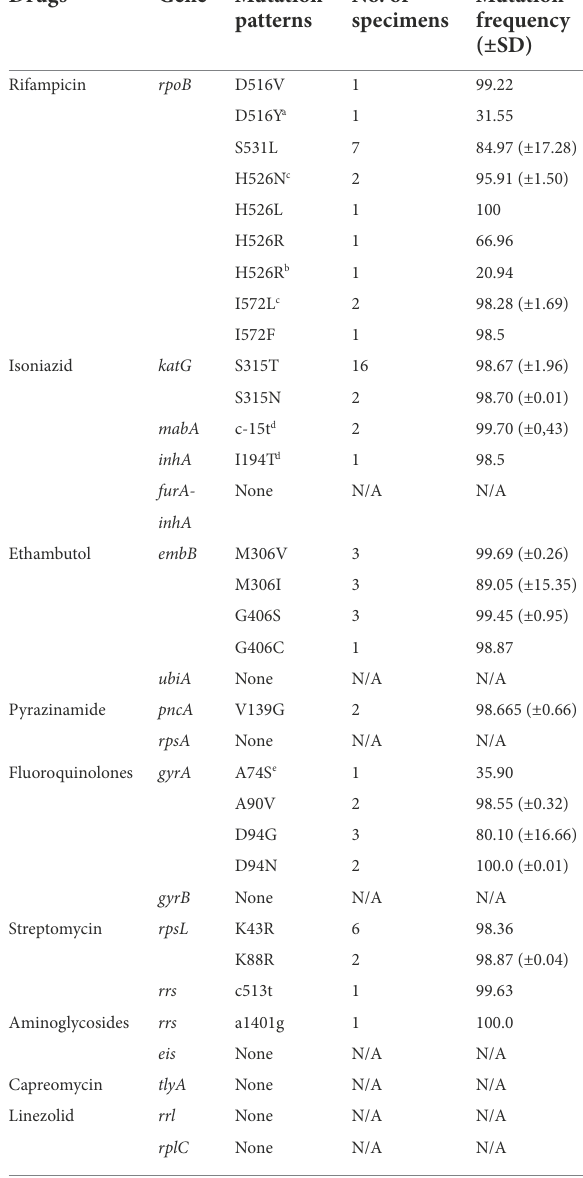
TABLE 3 Summary of drug-resistant mutations detected by TB-NGS. Drugs